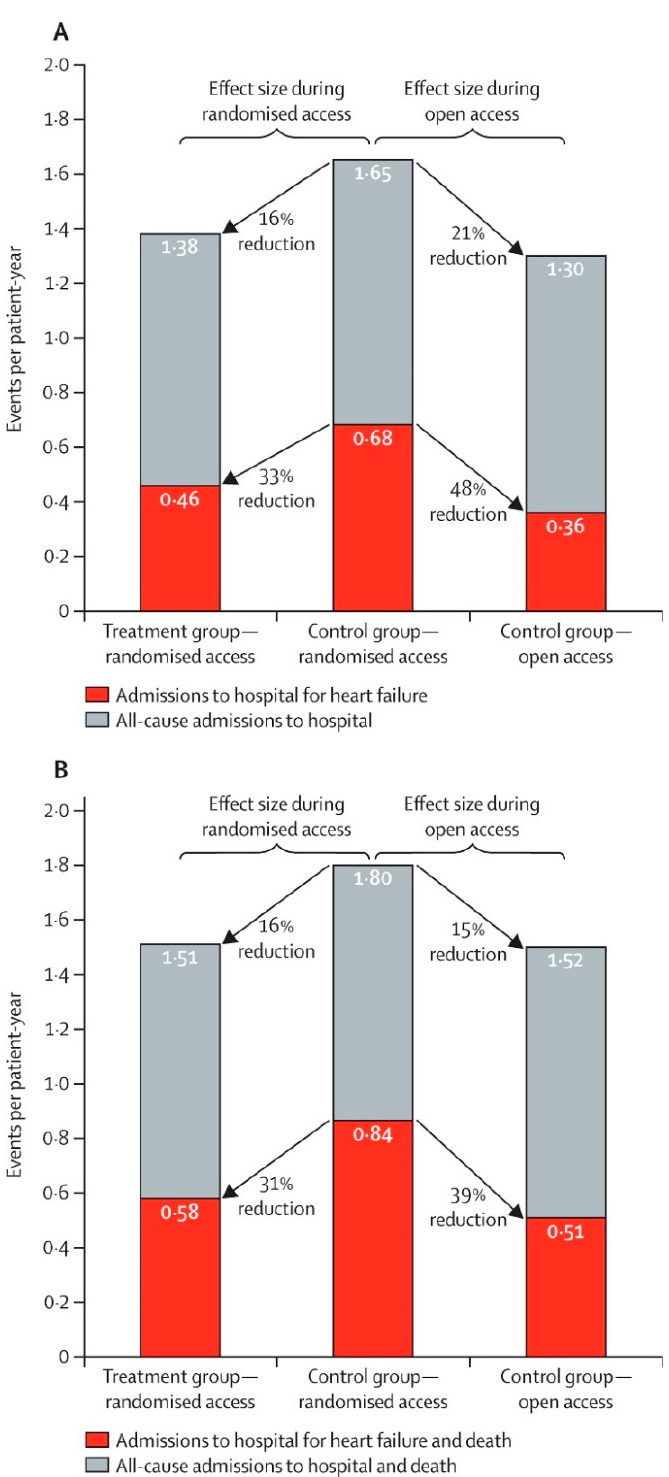
Figure 4. Long-term results from the CHAMPION trial: Effect of pulmonary artery pressure-guided heart failure management on rates of admission to hospital ( A ) and on combined rates of admission to hospital and mortality ( B ). Reprinted from The Lancet, Volume 387, Issue 10017, Abraham et al., Sustained efficacy of pulmonary artery pressure to guide adjustment of chronic heart failure therapy: complete follow-up results from the CHAMPION randomized trial, pages 453–461, Copyright 2016, with permission from Elsevier [5].